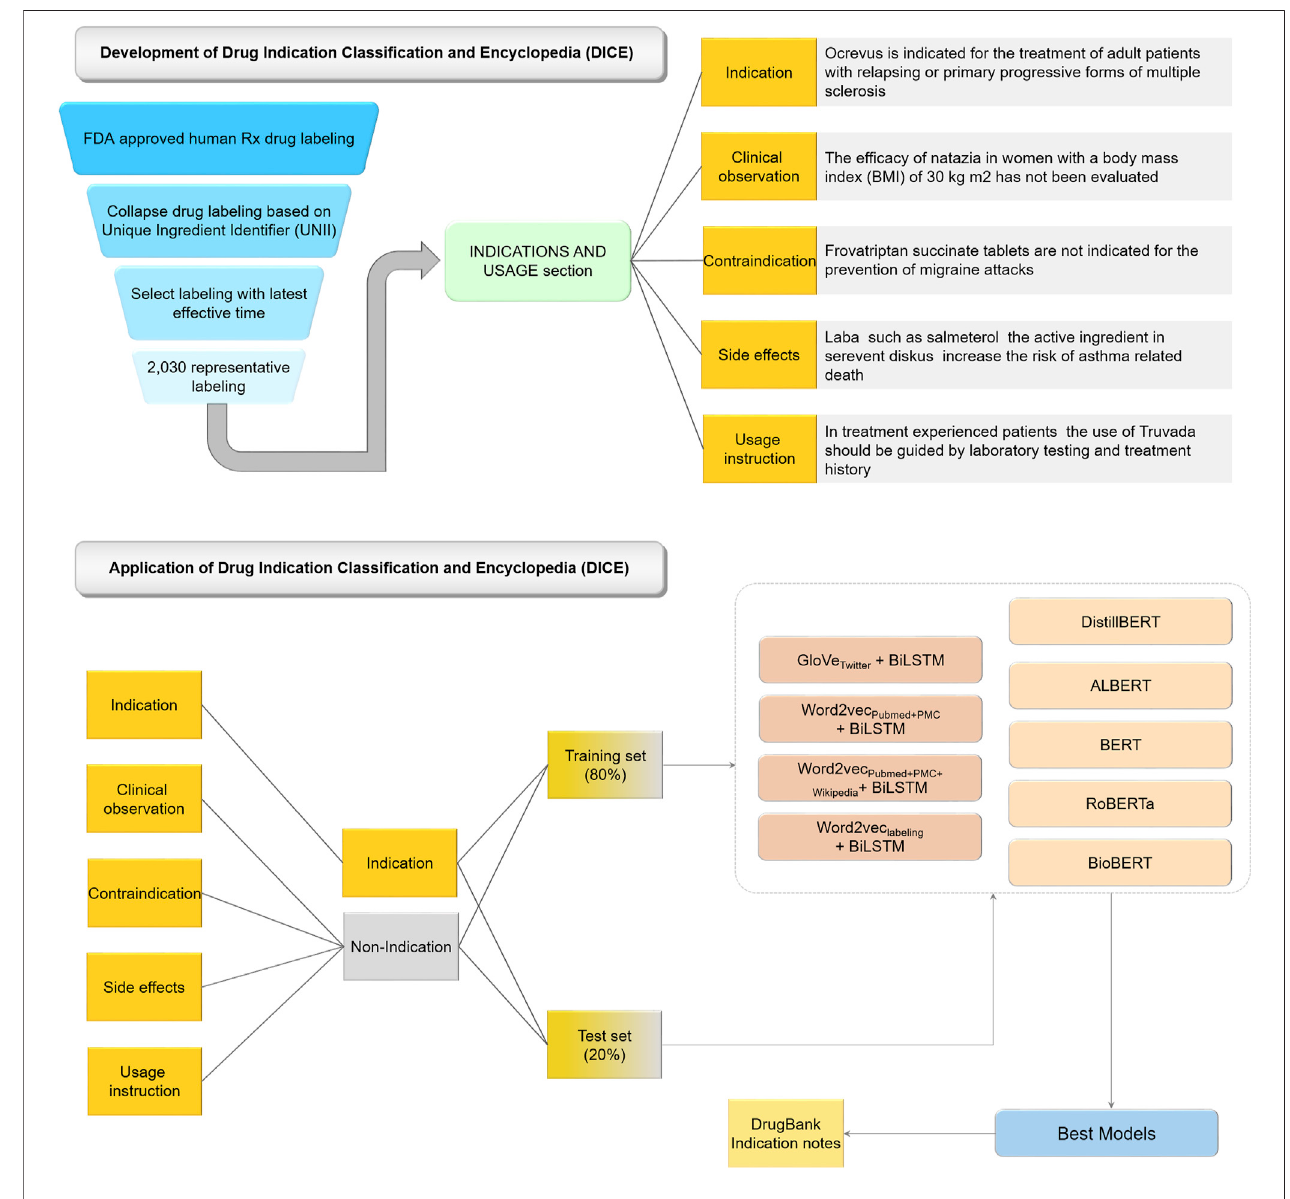
FIGURE 1 | Work fl ow of the